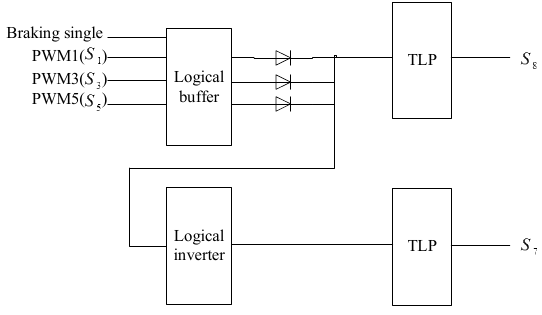
Figure 2. Active regenerative braking control scheme.